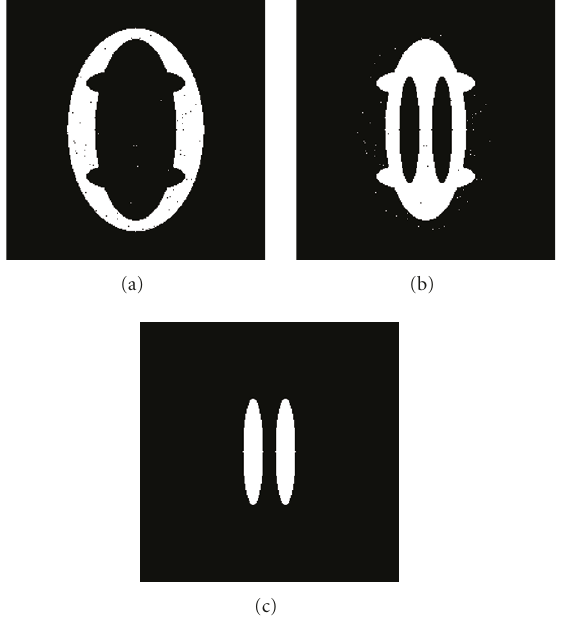
Figure 8: Classification results of AIS-CSA of simulated image with 10 dB noise: (a) GM; (b) WM; and (c) CSF.